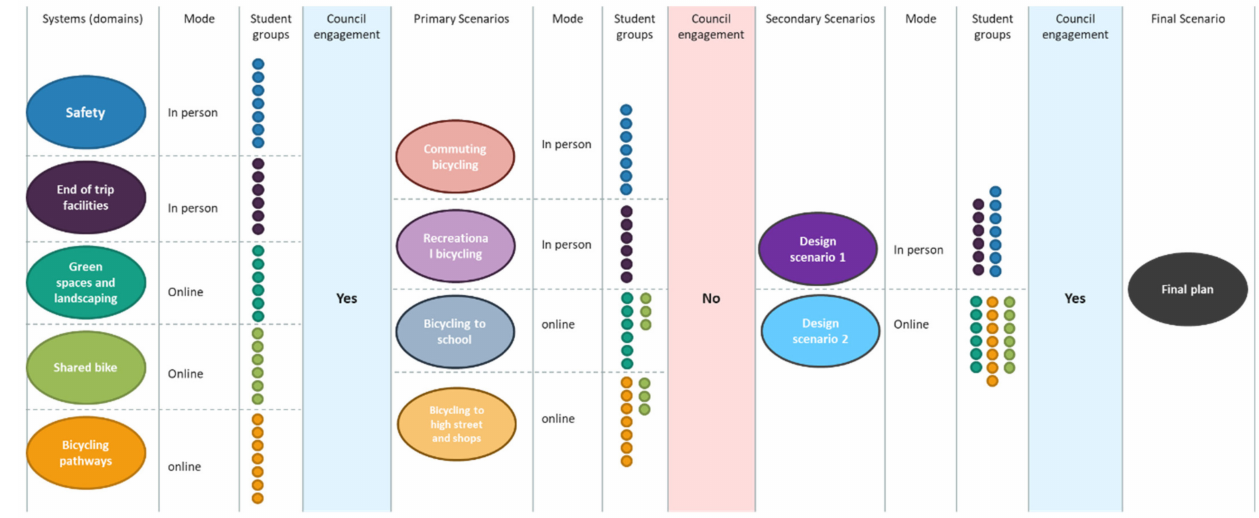
Figure 4. Groups and participants in the geo-design bicycling